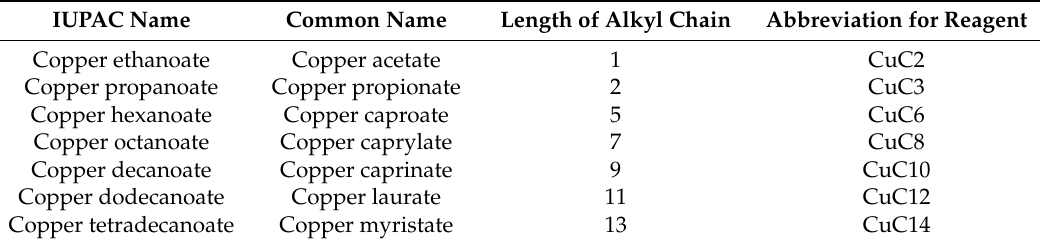
Table 1. Abbreviations for starting reagents.